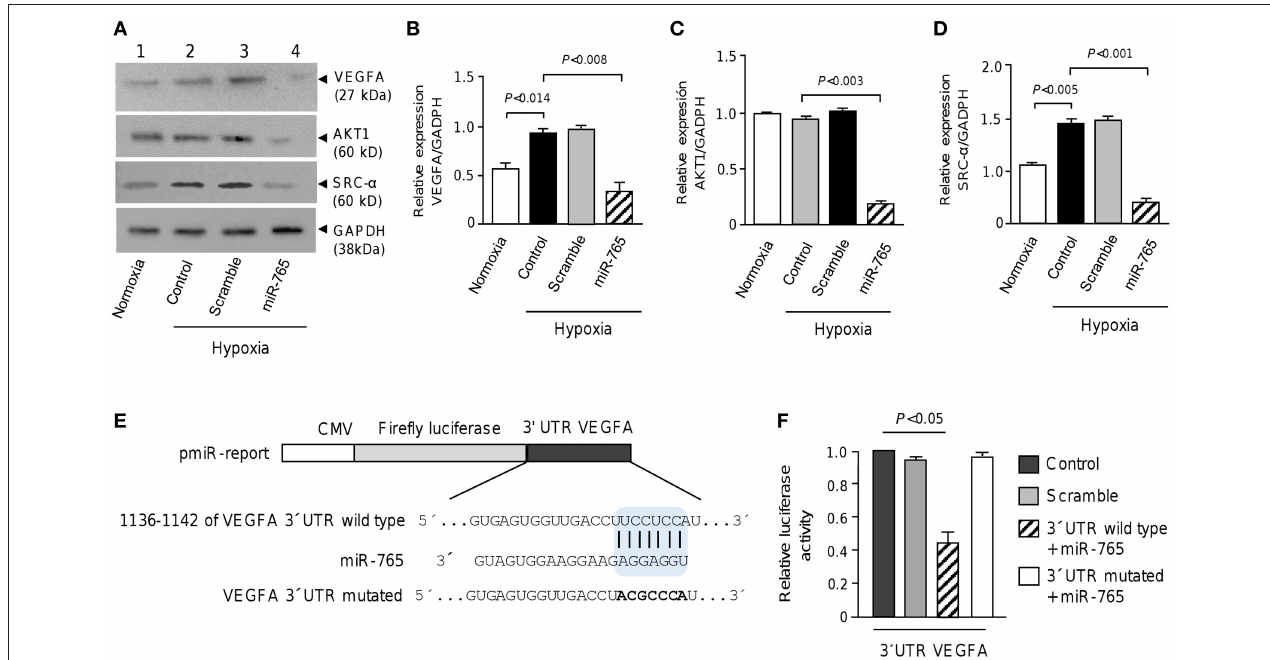
FIGURE 5 | miR-765 downregulates VEGFA, AKT1 and SRC- α proteins and target VEGFA . (A) Immunoblots of whole proteins extracts (30 µ g) from SKOV3 cells grown in normoxia or hypoxia (48h) using specific antibodies against VEGFA, AKT1, and SRC- α . GADPH was used as loading control. Lane 1, SKOV3 cells in normoxia; lane 2, non-transfected control cells and incubated in hypoxia; lane 3, cells transfected with scramble control and incubated in hypoxia; lane 4, cells transfected with miR-765 mimics and incubated in hypoxia. (B–D) Densitometric quantification of immunodetected bands in panel A. Experiments were performed by triplicate and data were expressed as mean ± S.D. (E) Schematic representation of p-miR report construct containing the 3 ′ UTR of VEGFA gene cloned downstream of luciferase gene. Seed sequence is indicated in colored blue box. Point mutations in the miR-765 binding sites of 3 ′ UTR of VEGFA gene is denoted in bold. Mutations in seed sequence are denoted in bold letters. (F) Luciferase assays in SKOV3 cells transfected with miR-765 mimics and wild type or mutated constructs described in panel E. Cells transfected with p-miR report plasmid alone or with scramble were used as controls. Data represent the mean ± S.D. of three independent